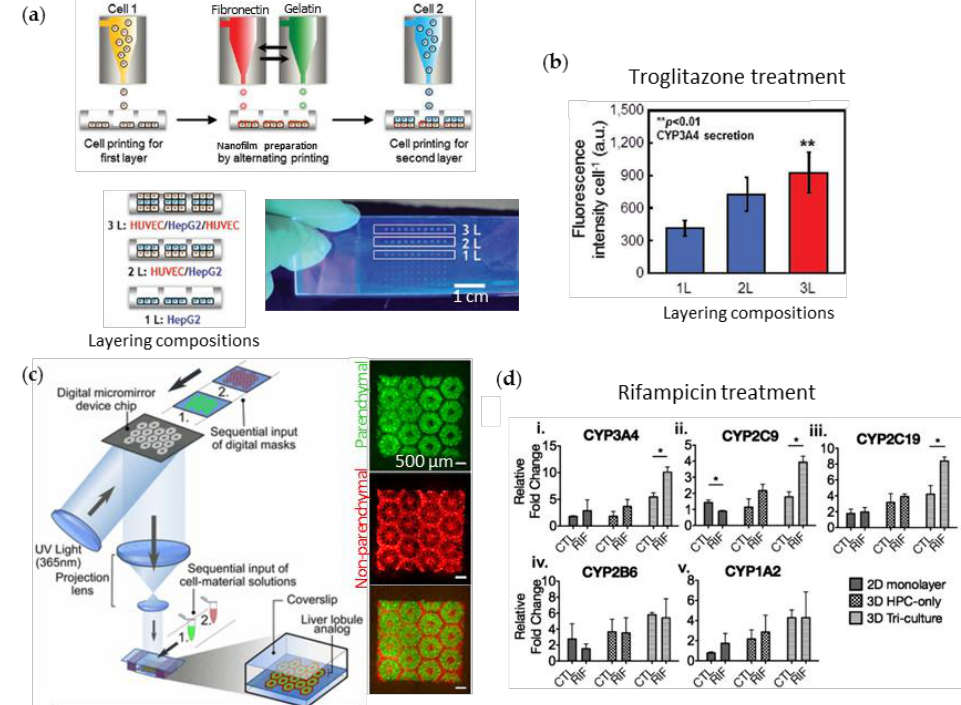
Figure 3. 3D cell-printed livers-on-chips. ( a ) Schematic diagram of inkjet printing into multiple micro-wells to create liver tissues with three layering compositions: 1L (HepG2), 2L (HUVEC/HepG2), and 3L (HUVEC/HepG2, HUVEC); ( b ) Hepatotoxic responses with increase in CYP450 3A4 (CYP3A4) secretions under troglitazone treatment; ( c ) Illustration of the sequential SLA process for building the liver lobule structure and ( d ) rifampicin-induced changes in expression of the CYP450 series in HPCs grown in the 2D monolayer, the 3D HPC-only model, and the 3D-printed model (3D Tri-culture). Reproduced with permissions from [79,80]